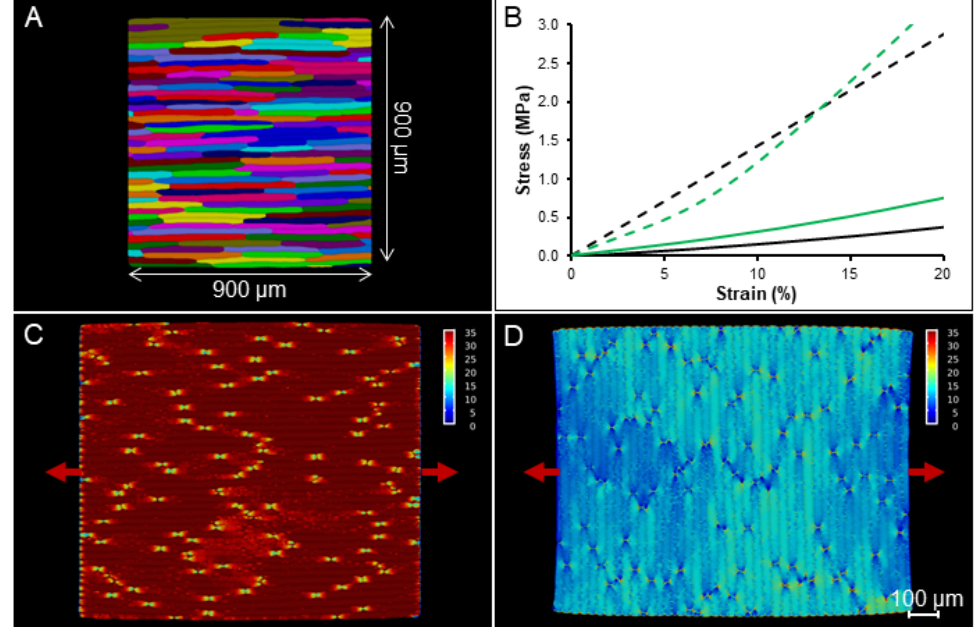
Figure 5. FEM simulation of the realistic onion template. ( A ) Cells segmented from confocal images of adaxial onion epidermis. The template used for the simulation was cut to a standard size of 900 × 900 µm. ( B ) Stress–strain curves generated from the FEM simulation in MorphoMechanX for the longitudinal ( B dashed line, C ) and transverse ( B solid line, D ) stretch. Black lines represent the simulations run with the engineering strain tensor, while green lines represent the simulations run with the Green–Lagrange strain tensor. ( C , D ) The images represent stretched tissue sections at 20% strain. The heatmaps show the mechanical stress (trace of Cauchy stress tensor). Red arrows indicate the direction of stretch. The scale bar is shown in the figure.